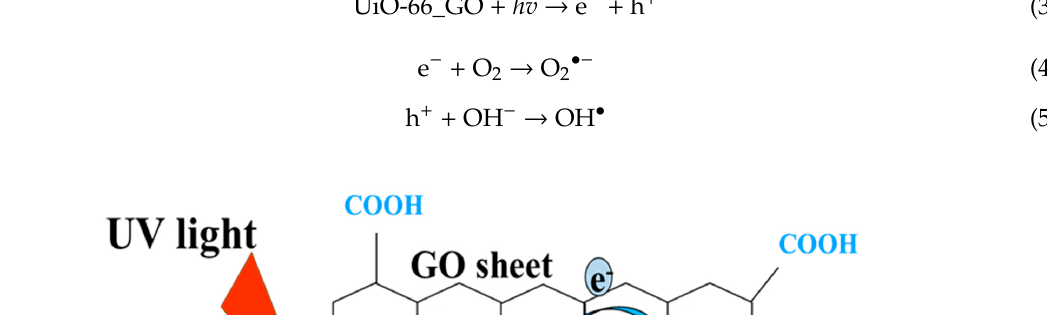
Figure 9. Photocatalytic performance over five cycles (experimental condition: initial CBZ concentration = 5 mg/L; pH = 7; concentration of UiO-66_GO-0.5 = 1 g/L; solution volume V = 50 mL). Plot and error bars represent averages and standard deviations from triplicate experiments.